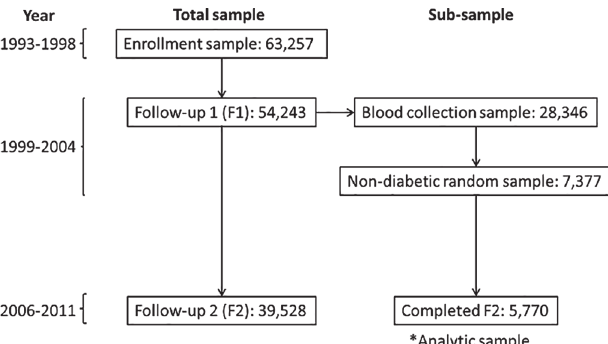
Fig 1. Timeline and assembly of sub-sample, The Singapore Chinese Health